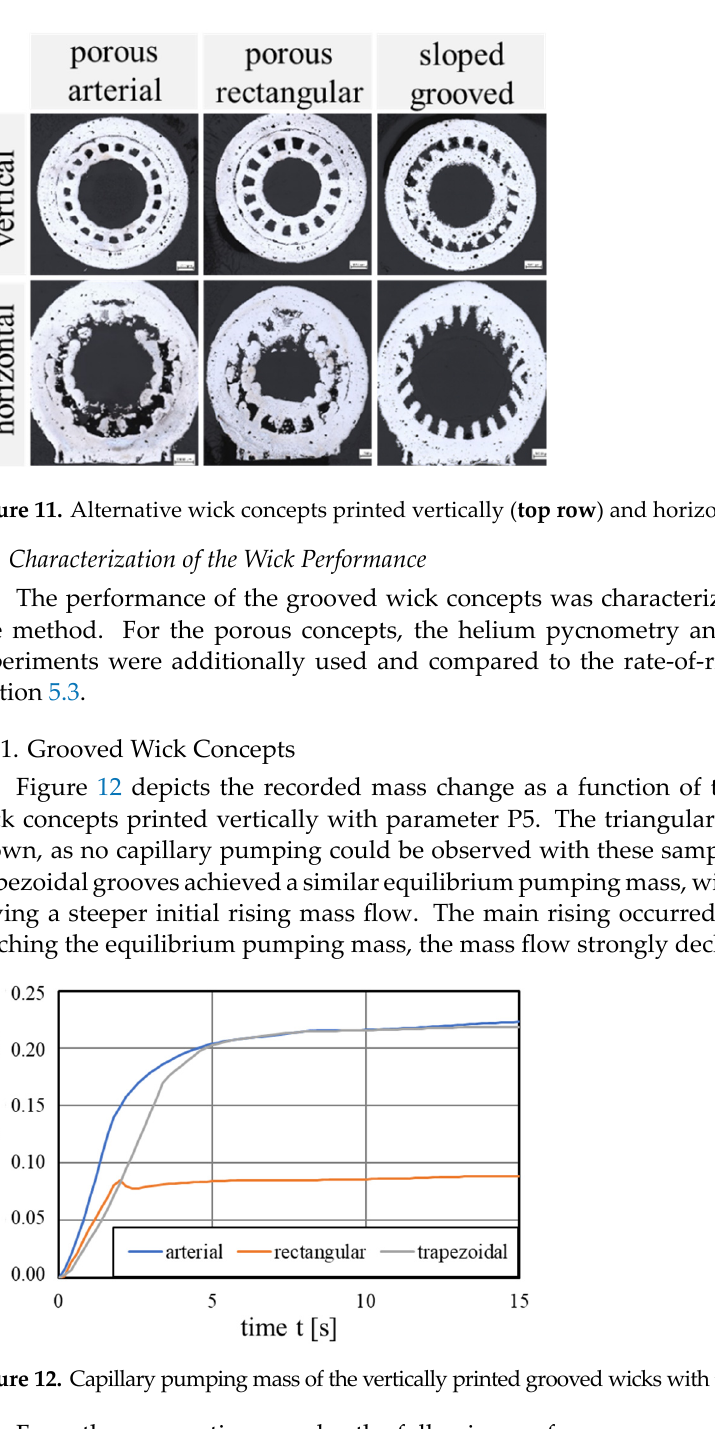
Figure 13. Performance of the trapezoidal and rectangular grooved wick dependent on the manu- facturing parameter, calculated by rate-of-rise experiments. 5.2.2. Porous Wick Concepts Regarding the heat pipe performance, the lower porosity reduced the expected wick permeability. The achieved porosities were in the range of conventionally sintered heat pipes [35] and therefore could have led to a similar performance. The resulting perfor- mance parameters are shown in Figure 14. The performance K/r (cid:2915)(cid:2916)(cid:2916) of up to 3.22 µm for sample P2 was the same order of magnitude as a comparable study [19], which achieved values between 1.04 and 7.14 µm. The performance of the horizontally printed samples here was around a factor 2 lower than the vertically printed ones, indicating a strong in- fluence of the printing orientation on the permeability of the porous wicks.